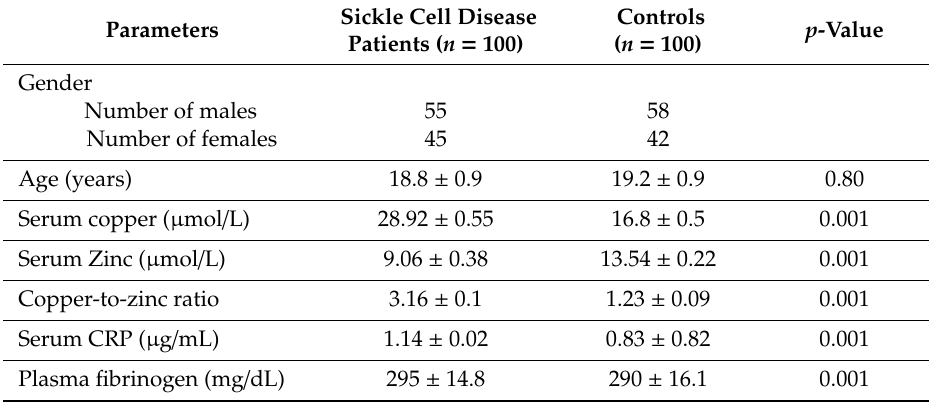
Table 1. Comparison of measured variables in sickle cell disease patients and controls.